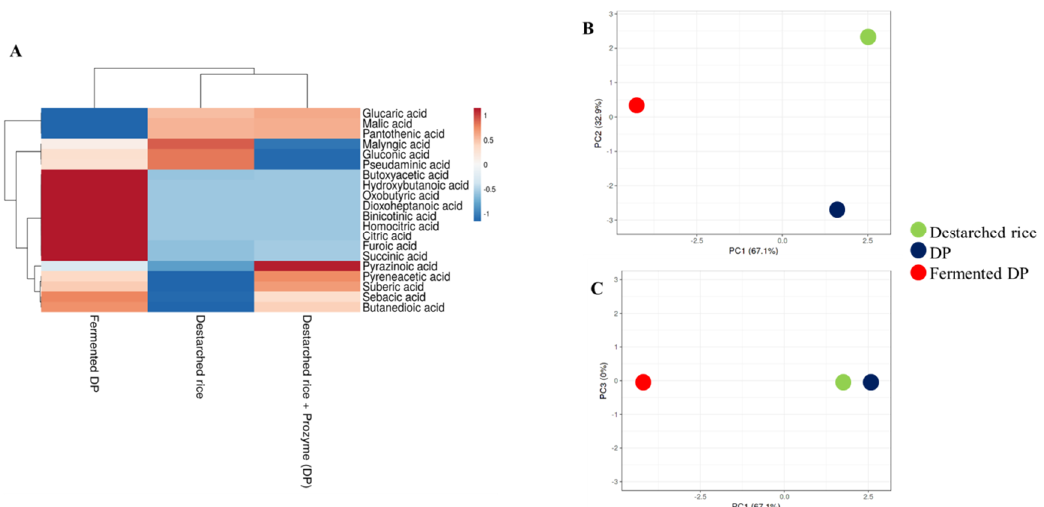
Figure 2. Relative levels of organic acids and volatile compounds in destarched rice, Prozyme treated destarched rice (DP), and fermented DP. ( A ) Heat map shows the different levels of organic acids present in the three samples. The color range from red to blue represents higher to lower levels of organic acids. ( B , C ) are principal component analysis (PCA) plots. ( B ) consists of PC1 and PC2, while ( C ) consists of PC1 and PC3. Red circles represent fermented DP, black represents Prozyme treated destarched rice (DP), and green represents destarched rice samples.